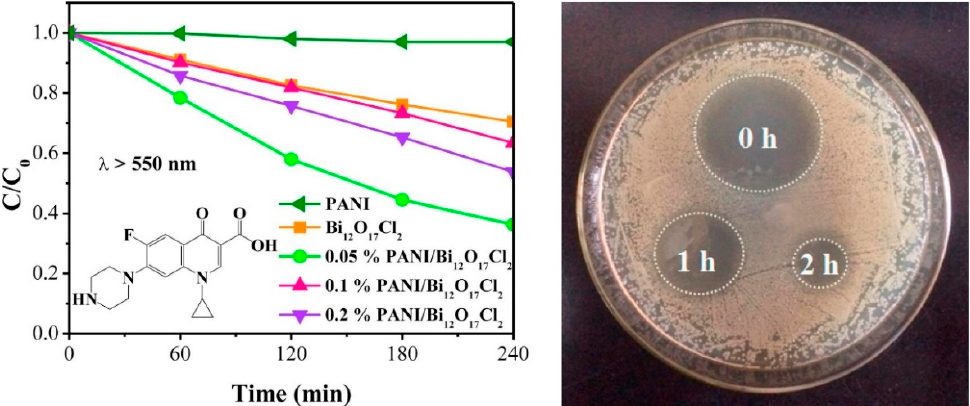
Figure 1. ( Left ) Visible light-driven photocatalytic degradation of CIP by various photocatalysts. ( Right ) The inhibition zone of the degraded CIP solution [17].